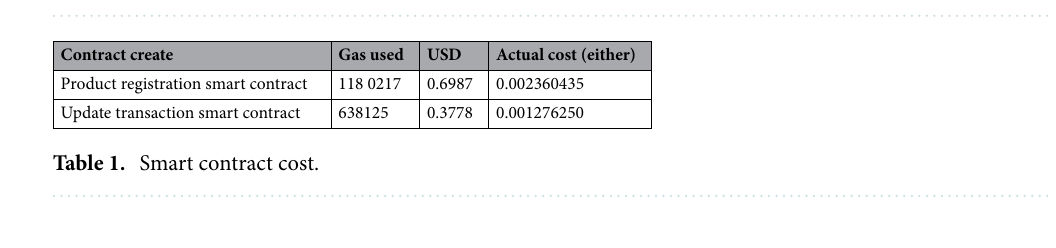
Figure 16. Integration of automatic refrigerator system for billing of tagged water bottles.